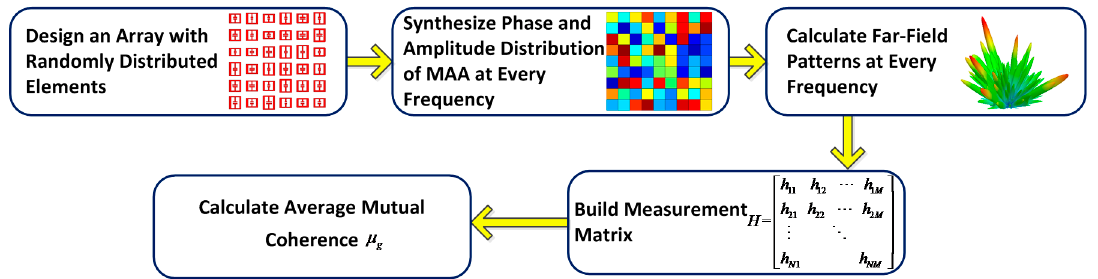
Figure 2. Flow chart of the μ g analysis procedure.